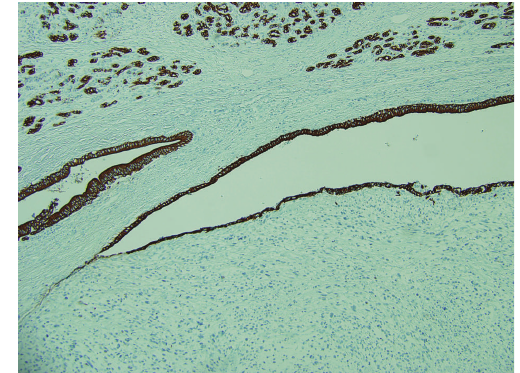
Figure 2: High power view showing highly pleomorphic cells and numerous/atypical mitosis (H & E 400x).